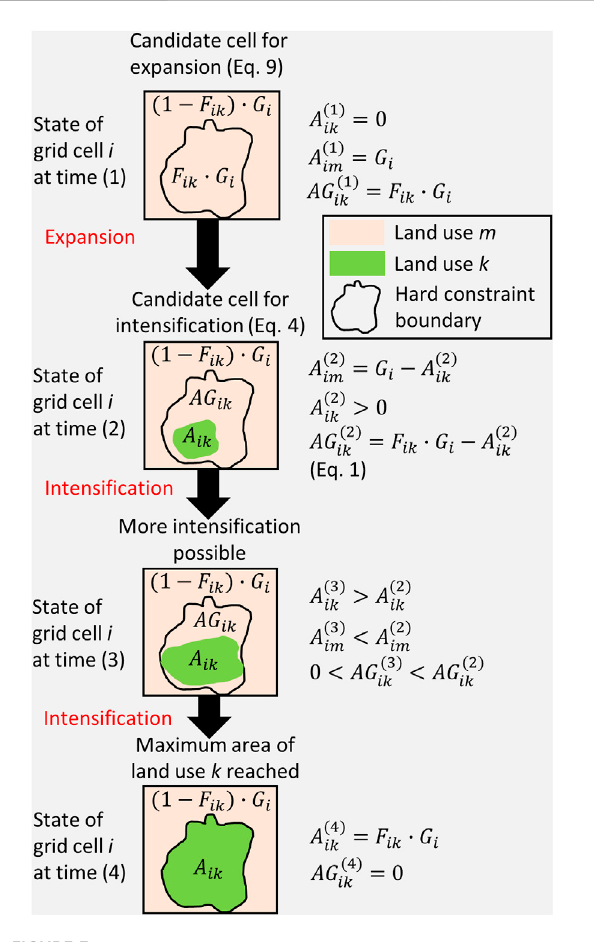
FIGURE 3 Land-use transition with hard constraints in the updated Demeter code. Land use k (increasing) can replace land use m (contracting) only to the point at which the area of land use k equals thefraction ofthe grid cell satisfying conditions of the hard constraint ( F ik ) multiplied by the grid area ( G i ). At time (1) the entire grid cell consists of a single land use, m . From time (1) to time (2), land use k expands into the grid cell, replacing someofland use m . From time (2) to time (3), intensi fi cation of land use k replaces more of land use m , but there is still room for more intensi fi cation ( AG ik ). From time (3) to time (4), land use k fi lls all the area permitted by the hard